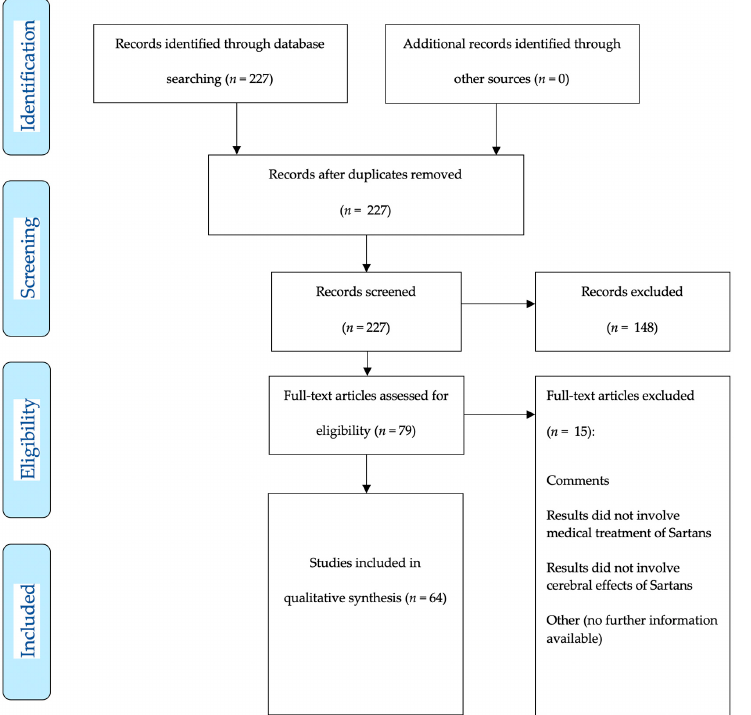
Figure 1. Two hundred and twenty-seven articles (published 01-01-1980–01-07-2019) were detected for preclinical and clinical research articles. After manual abstract screening for preclinical research articles only, 79 articles remained for further analysis. Each of the 79 articles was explicitly screened for potential drug applications after ischemic stroke. Finally, 64 articles were included for qualitative analysis.